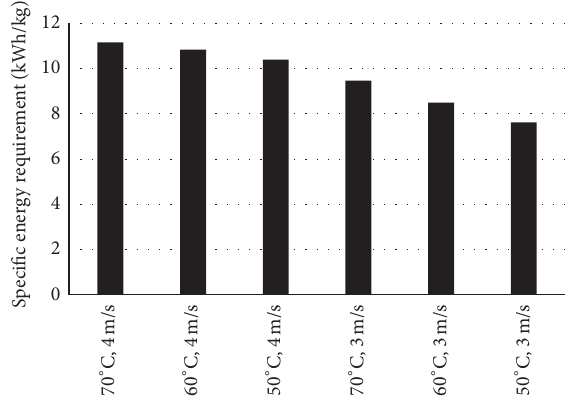
Figure 5: Specific energy required for drying of green